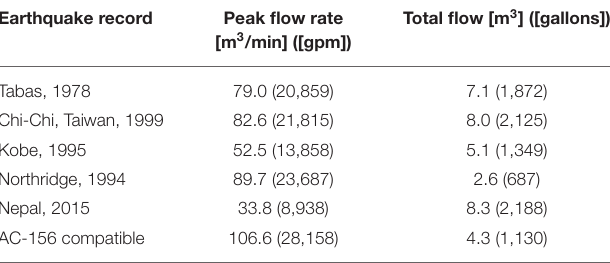
TABLE 3 | Peak demand flow rate and total demand flow required to reproduce the tri-axial strong ground motion records defined in Table 2 ; bare table condition. Earthquake record